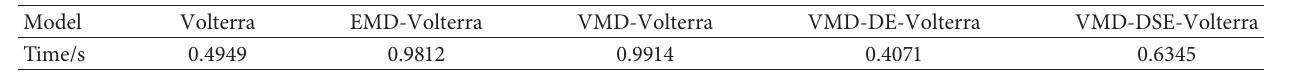
Figure 14: Bar chart of model error index. M1: RBF, M2: SARIMA, M3: Volterra, M4: EMD-Volterra, M5: VMD-Volterra, M6: VMD-DE- Volterra, and M7: Table 6: Running time of each prediction model.